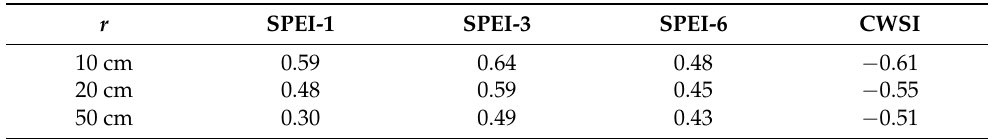
Table 1. The correlation ( r ) between soil relative humidity at different depths (10 cm, 20 cm, 50 cm) and SPEI (1, 3, 6 months) and